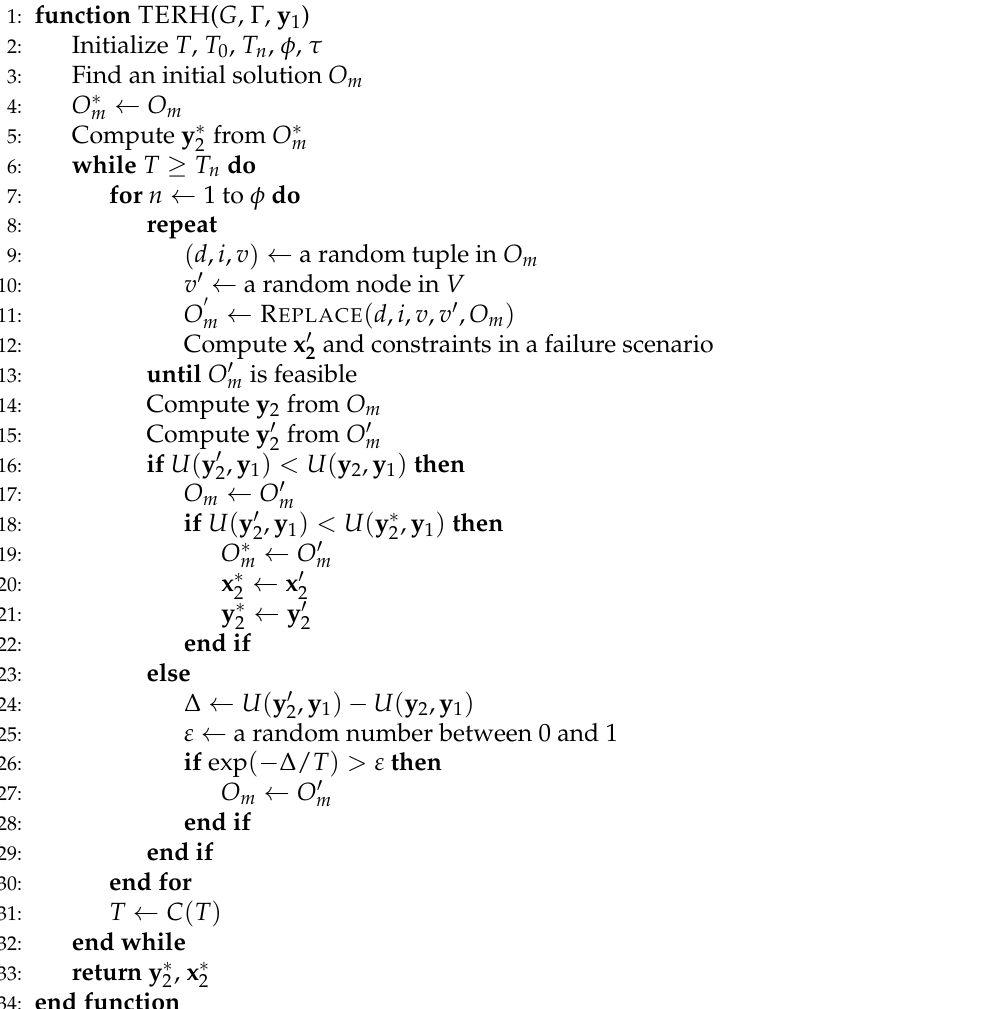
Algorithm 1 Simulated Annealing-based approximation algorithm for